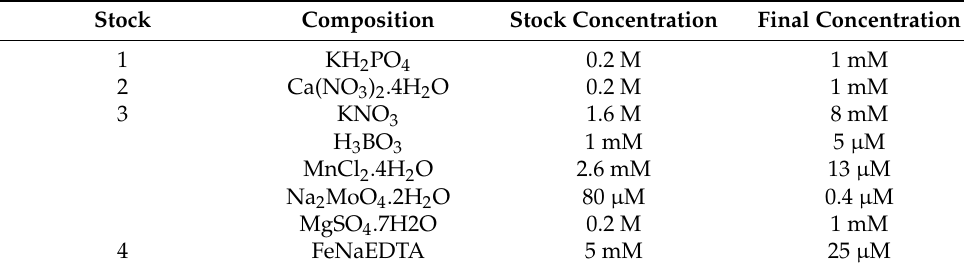
Table A2. The different treatments used to test the salt tolerance in (adapted) NDNE. Treatment n ◦ 1: the reference medium; n ◦ 2,3,4 different dilutions of NDNE with demineralized water; n ◦ 5